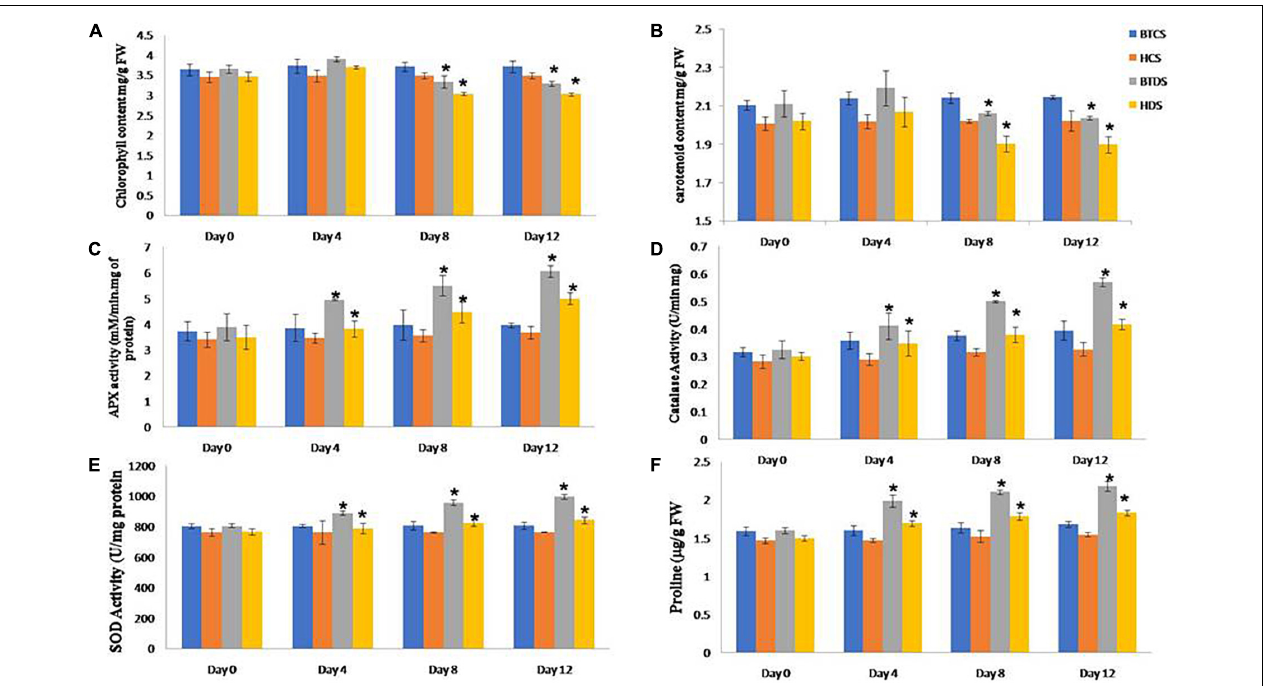
FIGURE 2 | Biochemical characterization of BT and Non-BT cotton lines against drought stress condition. For analyzing the stress tolerance ability of Bt and Non-Bt cotton plants at the 1-month stage, drought stress (200 mM mannitol) was applied for 10 days at 30 ◦ C. Later, the treated plants were allowed to grow under normal conditions. After 0, 4, 8, and 12 days of mannitol stress, the samples were used for analysis. Data on (A) chlorophyll content, (B) carotenoid, (C) APX, (D) catalase, (E) SOD, and (F) proline were recorded and photographed. In each treatment, 10 seedlings of BT and Non-BT varieties were used. Bar represents mean and I represents SE from three independent experiments. ∗ indicates significant differences in comparison with the C at P < 0.05, FW represents fresh weight.